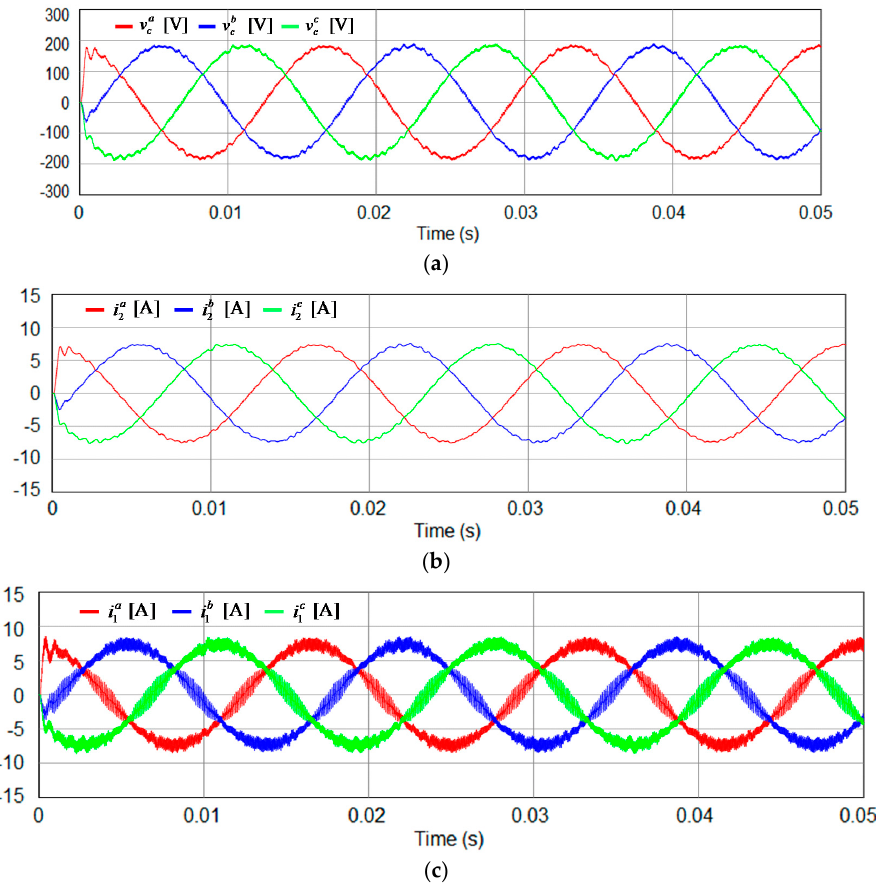
Figure 9. Simulation results for the proposed control scheme under islanding modes at the natural reference frame. ( a ) Capacitor voltage responses; ( b ) Current responses in critical loads; ( c ) Inverter-side current responses.